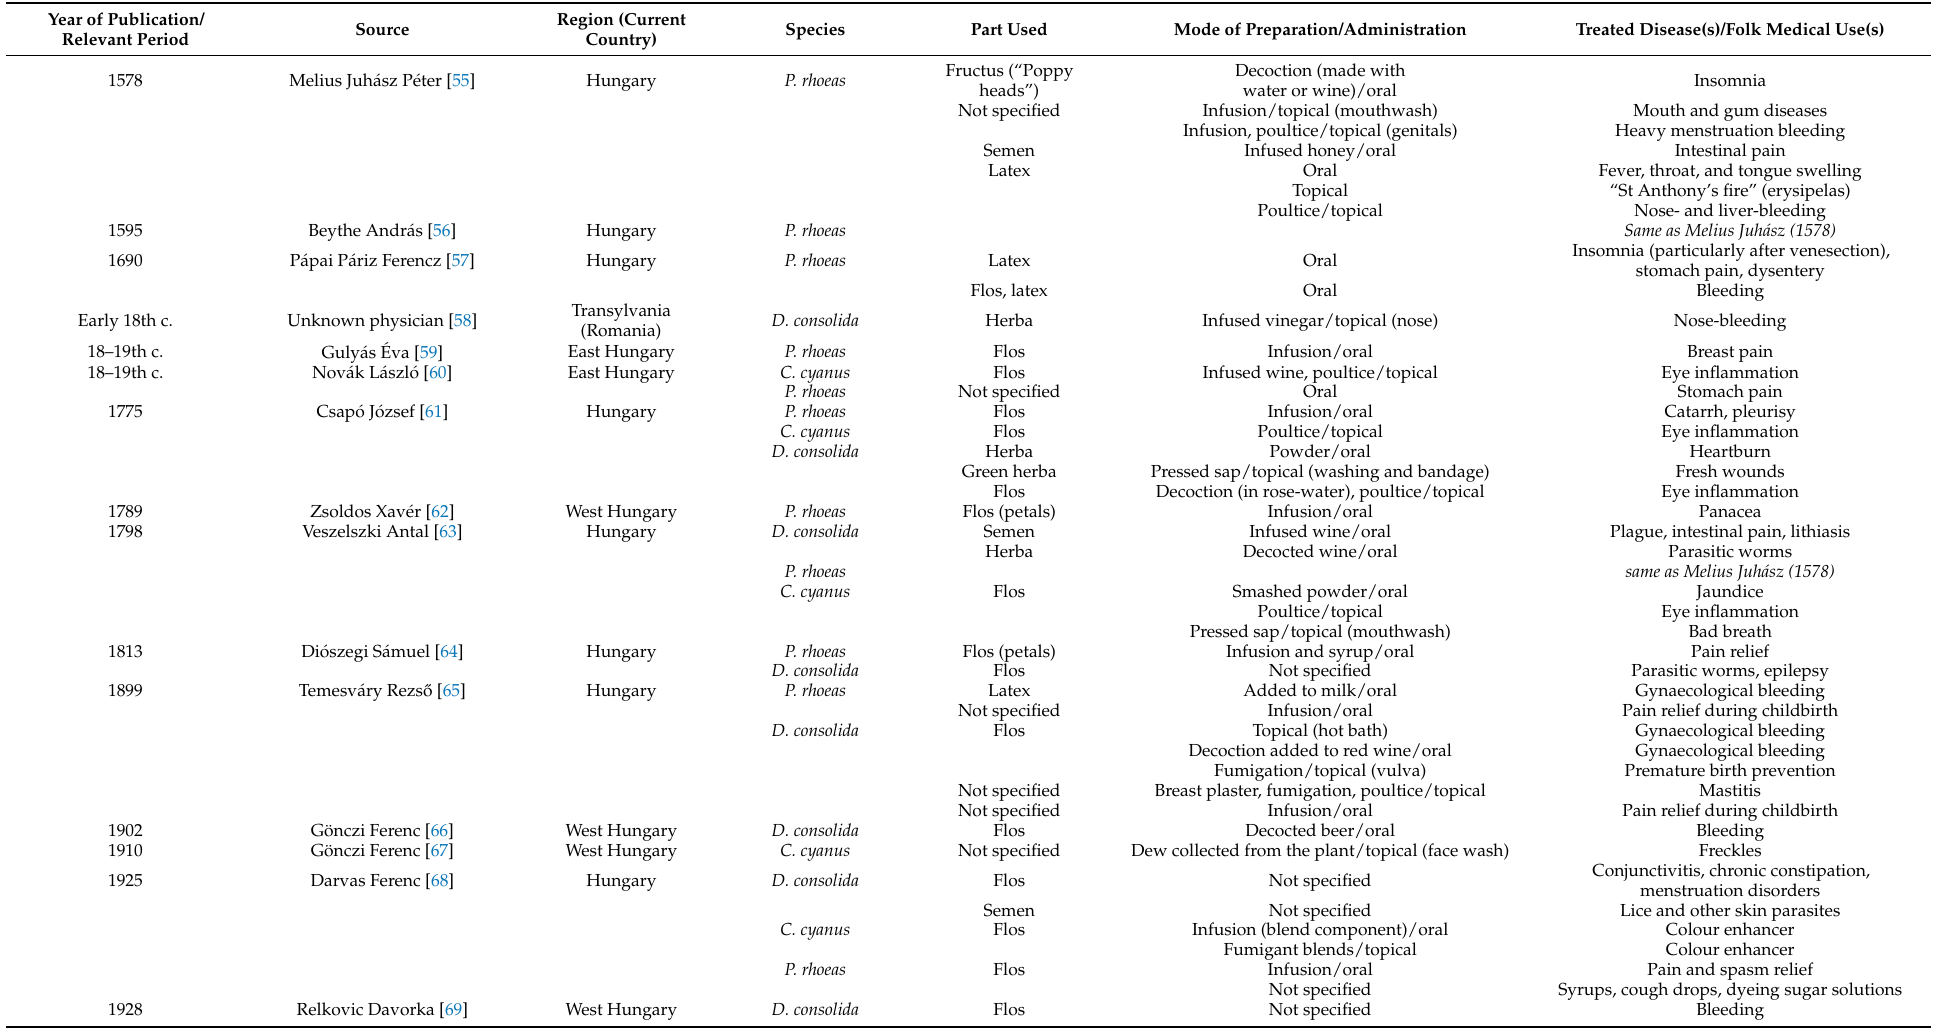
Table 1. Records on the medicinal and veterinary uses of Papaver rhoeas , Centaurea cyanus, and Delphinium consolida between 1578 and 2018 in the Carpathian